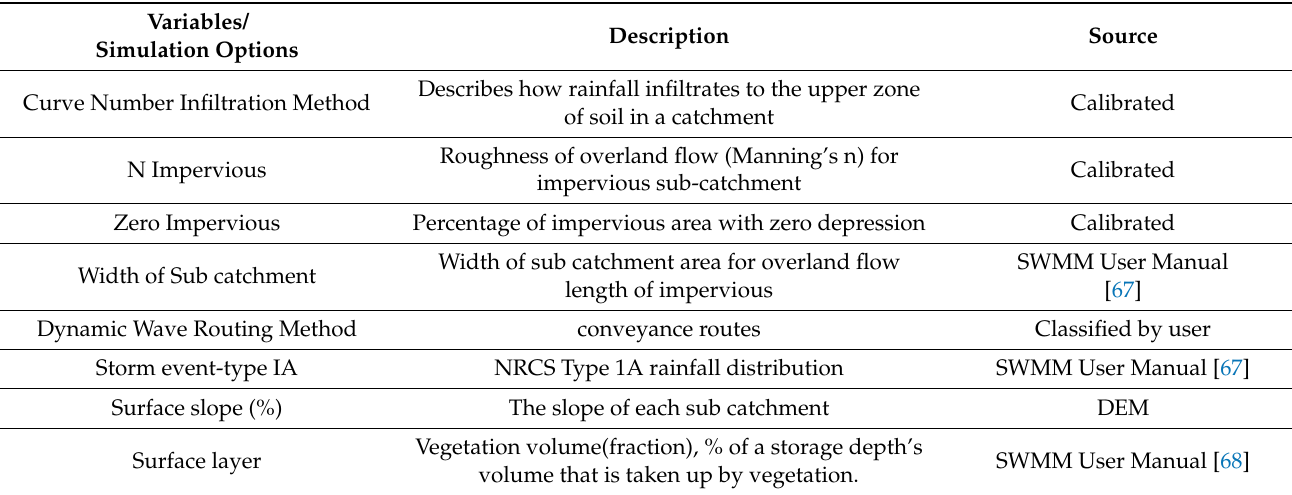
Table 1. List of main variables used for the SWMM model development.